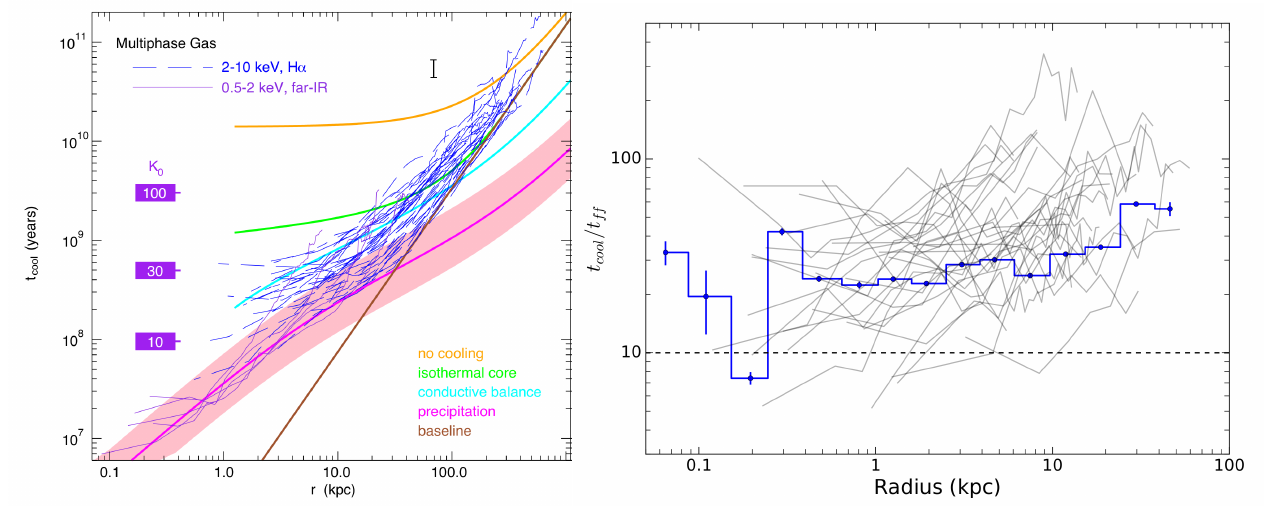
Figure 6. Observed timescales profiles in the IGrM (mainly related to TI). Left : Cooling time profiles for a sample of cool-core clusters (blue) and groups (magenta) hosting multiphase gas (H α , CO; figure reproduced from Voit et al. [159], arXiv author’s version). The observed profiles are compared with the ’baseline’ structure formation profile (maroon) and the typical simulation threshold t cool / t ff ∼ 10 (pink). Right : The ratio of the cooling time to free-fall time in a sample of groups and ellipticals (the figure reproduced from Babyk et al. [155]; the average is shown with a blue